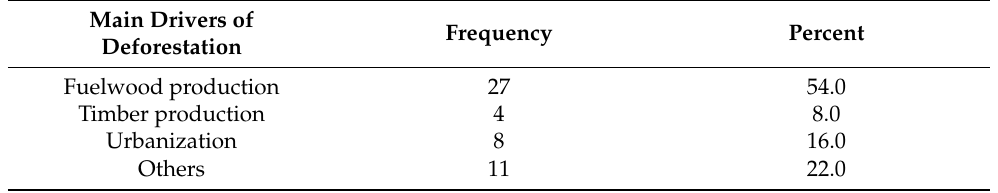
Table 14. Main drivers of deforestation in Murree.